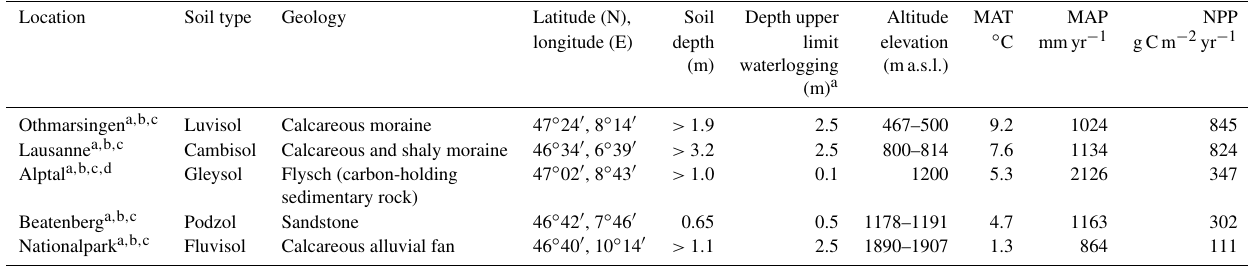
Table 1. Overview of sampling locations and climatic and ecological parameters. Location